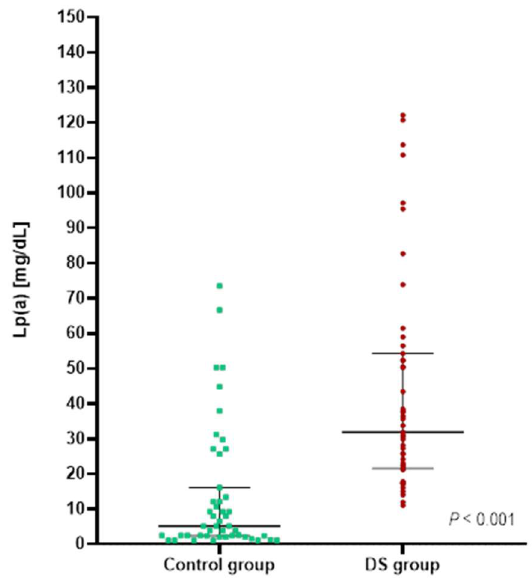
Figure 1. Lp(a) levels in patients with Down syndrome (DS group) and patients without Down syndrome (control group). Values are presented as medians (25–75th percentiles) and assessed using the Mann–Whitney U test.